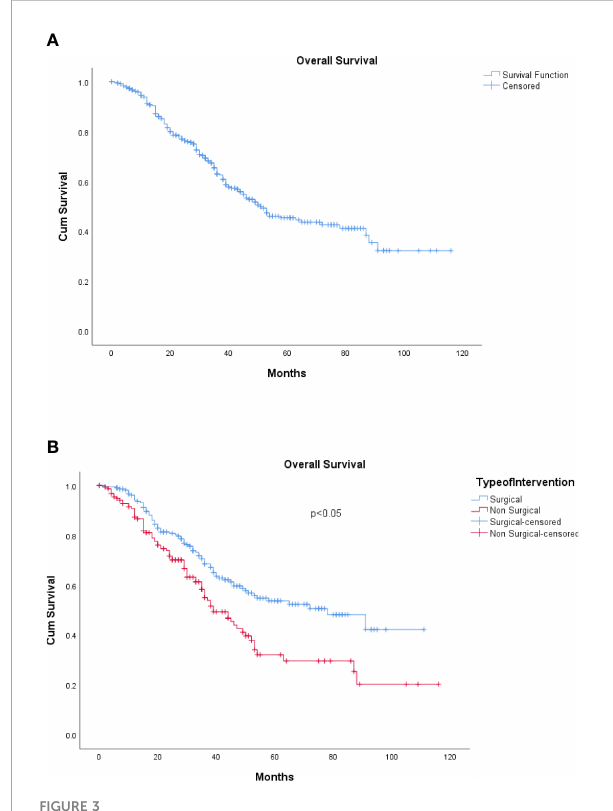
FIGURE 3 (A) Overall survival. (B) Overall survival: surgical and non-surgical LDT. LDT, liver-directed